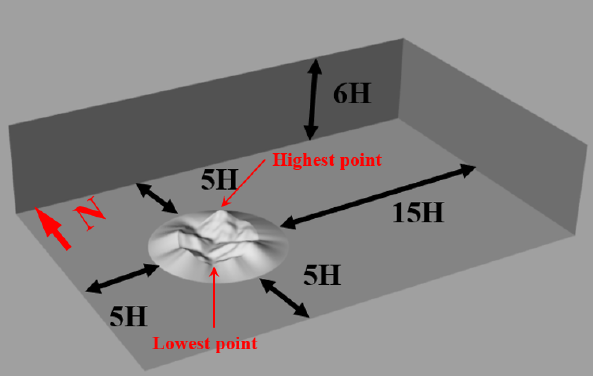
Figure 2. Calculation of domain size.